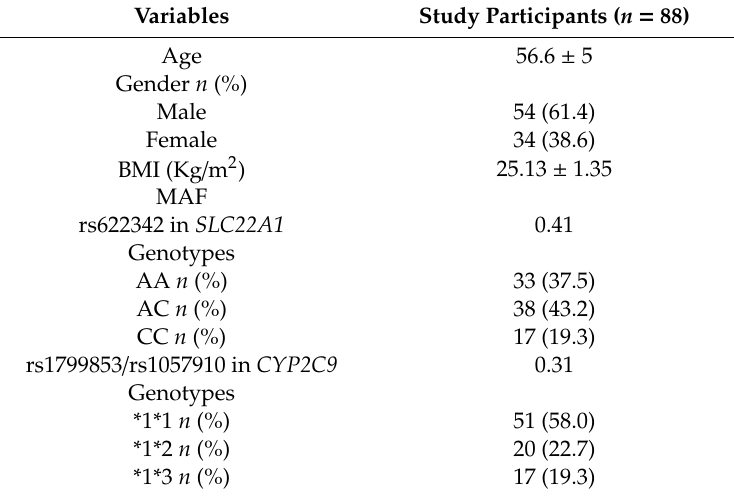
Values are arithmetic mean ± SD for continuous variables. Categorical variables are shown as number ( n ) and percentages (%). n : sample size. BMI: body mass index; MAF: minor allele frequency; SLC22A1 : Solute